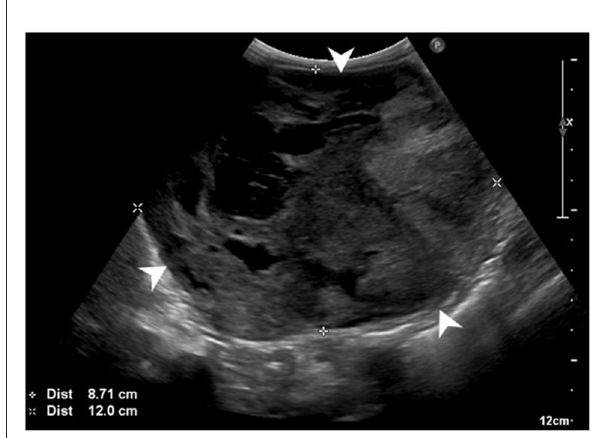
FIGURE1 Preoperative abdominal ultrasonographic study. Large, cavitated, heterogeneous mass (white arrowheads) arising from the left